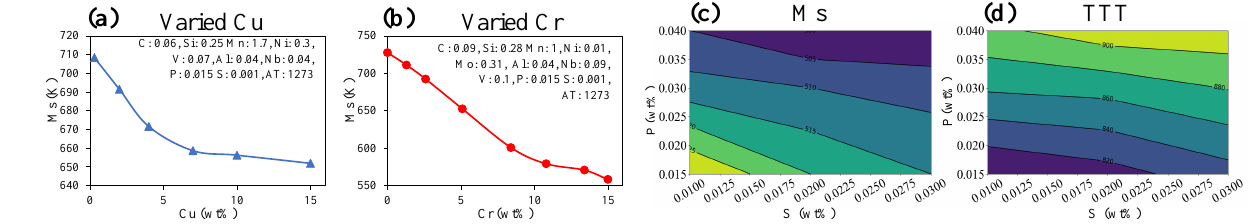
Figure 9. The influence of elements on properties in framework prediction. ( a , b ) The influence of single element on Ms. ( c , d ) Contour map. Table 4. Verification of alloy phase prediction results of Co-Cr-Fe system high entropy